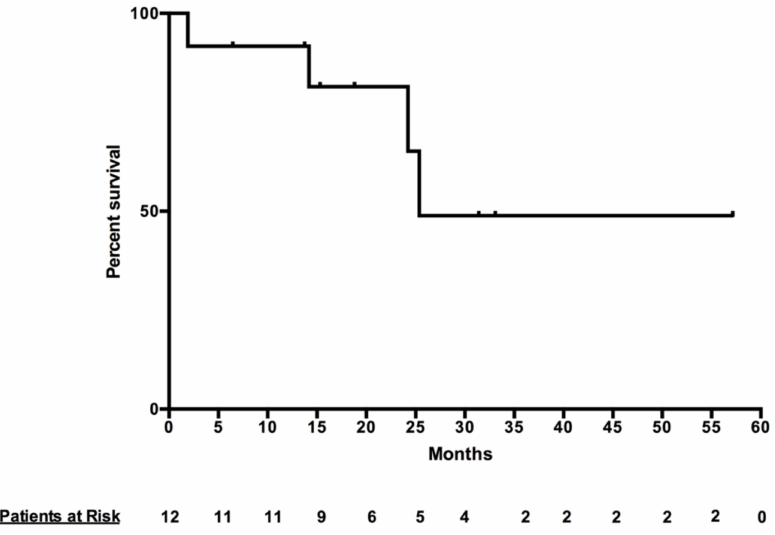
Figure 2. Patient Progression Free